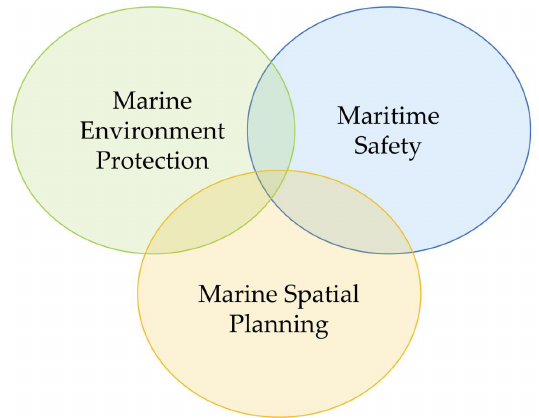
Figure 7. Marine information domains. Reproduced with permission from reference [24]. Copyright 2020, NTUA Cartography